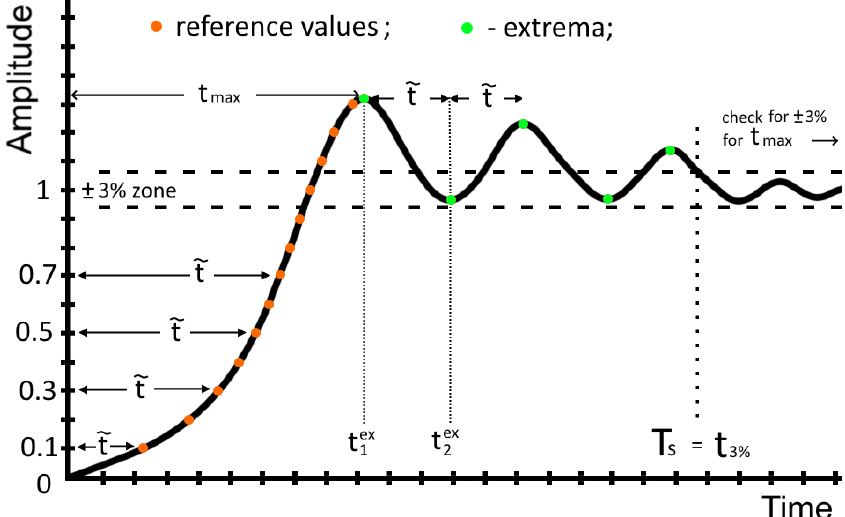
Figure 11. The algorithm analyses a simulated transient response. The orange points represent the times when the output signal crosses a new reference value. The green points are the signal’s extrema. The key parameter of this process is the current recorded reference time ˜ t . The two mechanisms for when this value changes are described (see the algorithm’s